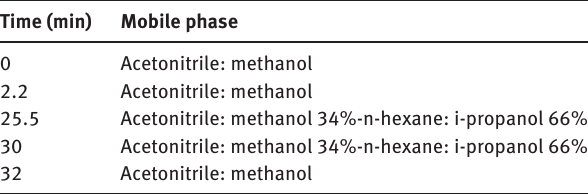
Table 2: Gradient profile of HPLC analysis. Time (min) Mobile phase